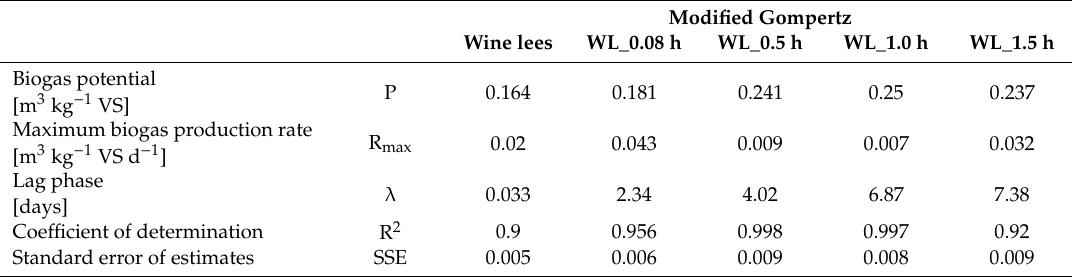
Table 5. Kinetic adjustment results of AD tests after electro-oxidation pre-treatments.